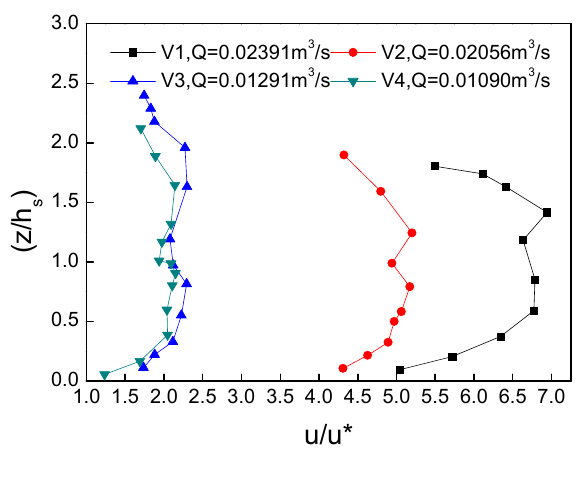
Figure 6. Vertical velocity distribution profiles.